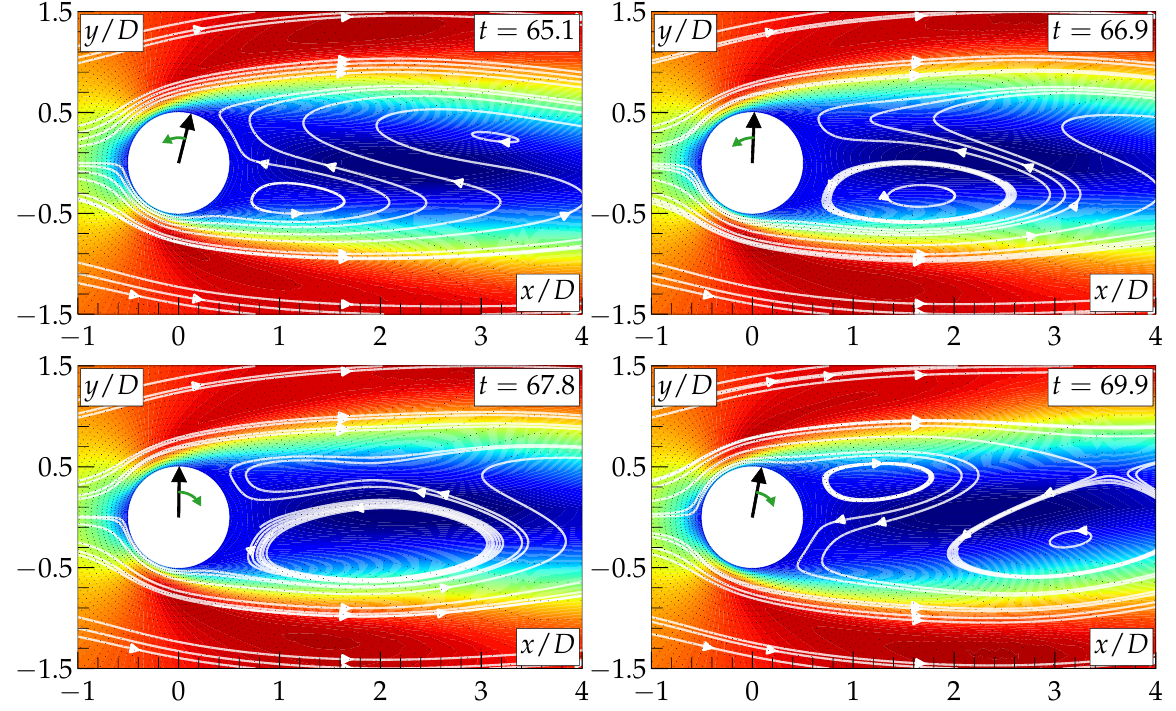
Figure 8. Instantaneous streamwise velocity field for c1e80 at particular time instants for t = 65.1, 66.9, 67.8 and 69.9, respectively, highlighted in Figure 7 by four triangles. Black arrow denotes the instantaneous angular position of the rotating cylinder while the green circular arrow indicates the direction of the